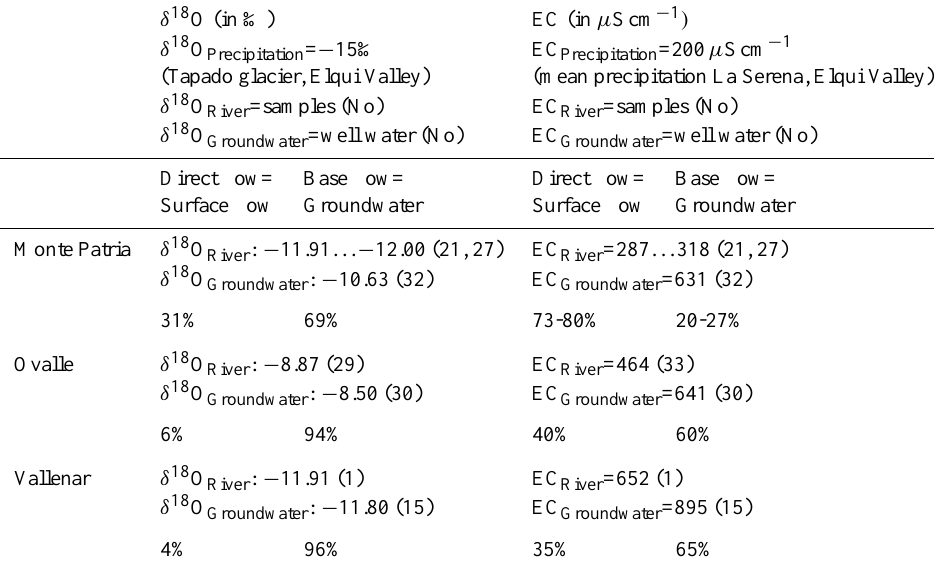
Table 3. Contributions of groundwater to the total river flow in areas of groundwater